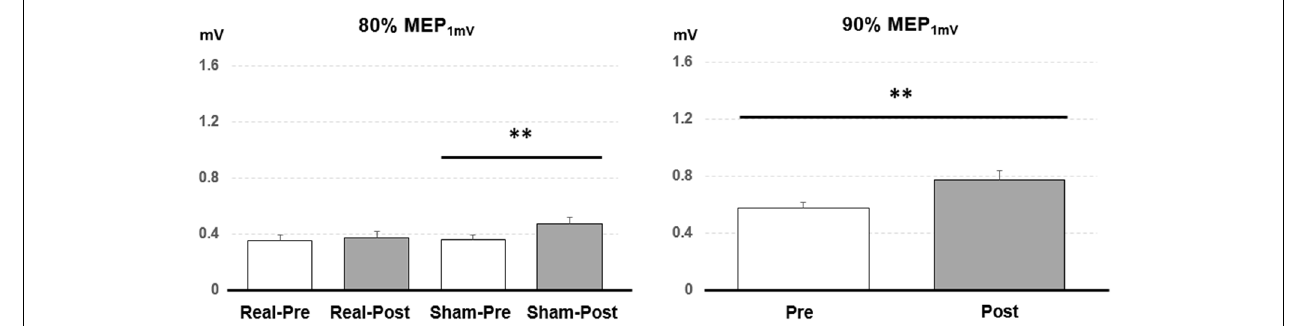
FIGURE 3 | Post hoc comparisons of the motor evoked potential (MEP) evoked with different TMS intensities for the 15 subjects. MEP 1 mV means the TMS intensity inducing on average 1 mV MEP amplitude in the resting abductor pollicis brevis (APB) muscle. The MEP amplitude showed a significant facilitation after the sham